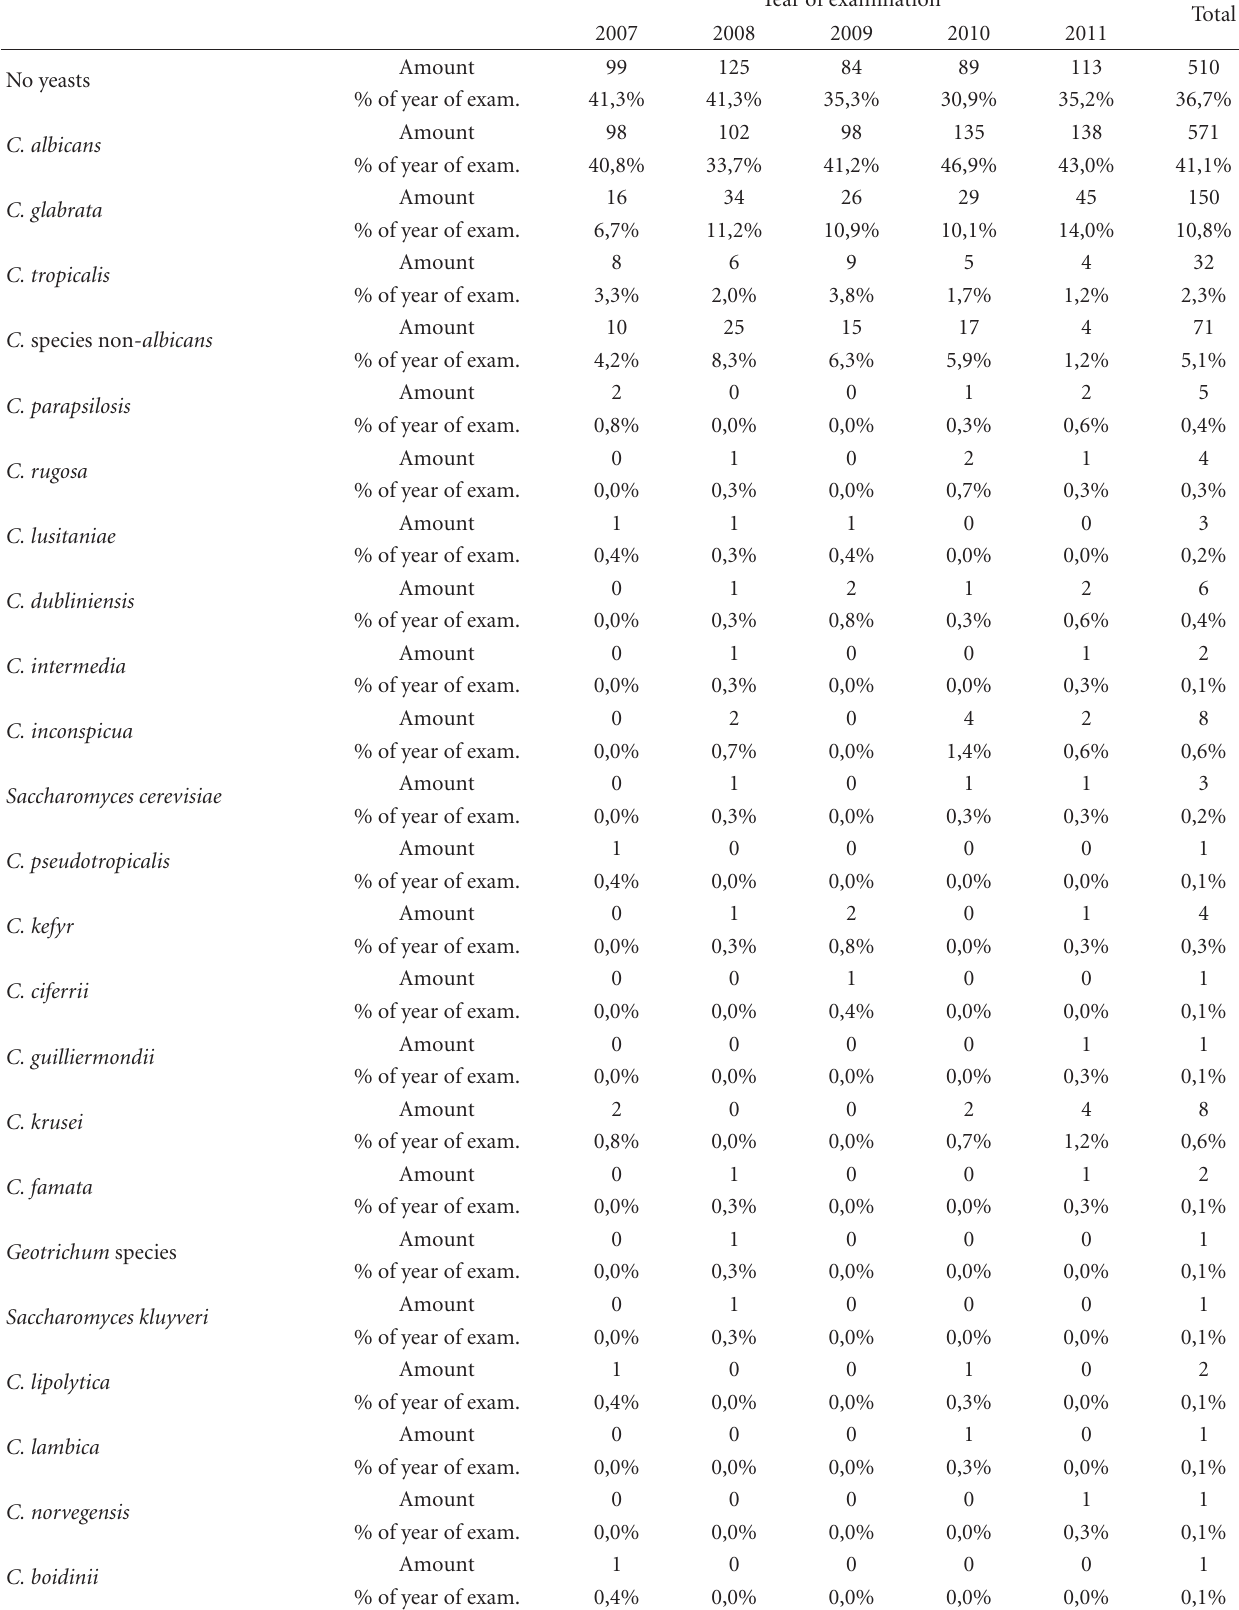
Table 7: Distribution of yeasts results according to the year of